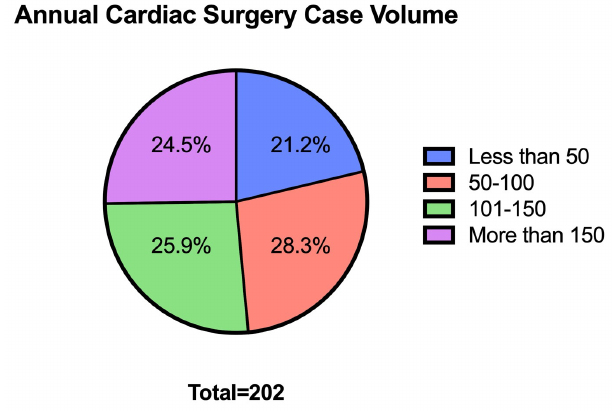
Fig. 2 - Annual cardiac surgical case volume by staff (graduated) surgeon respondents